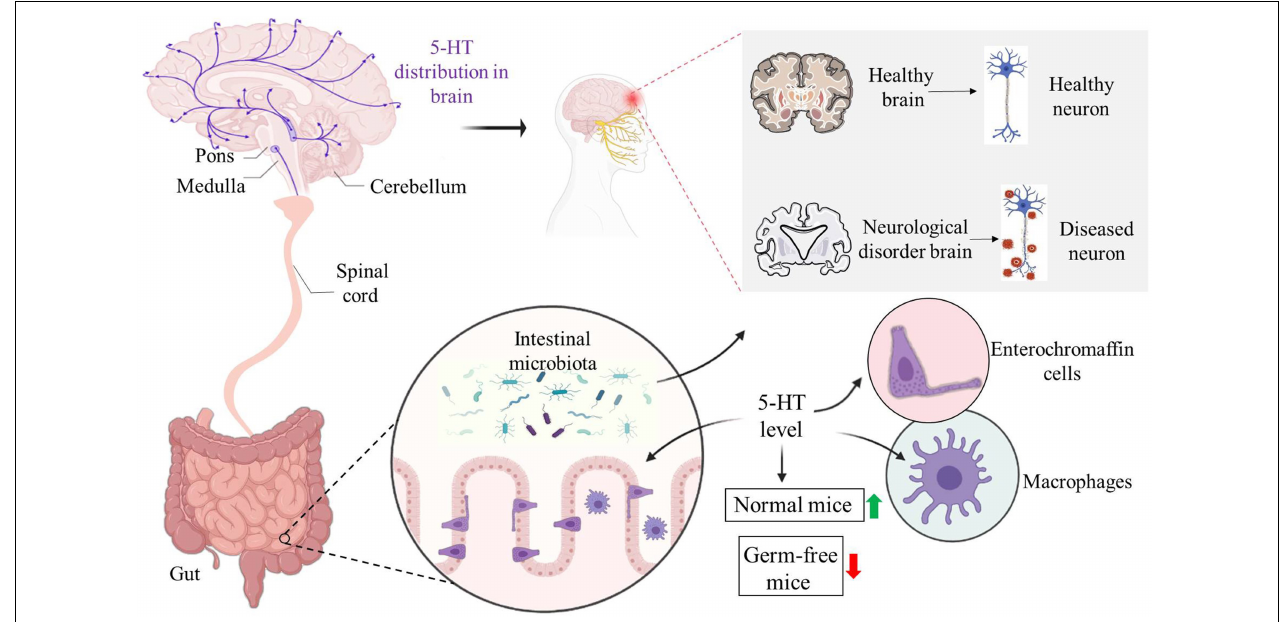
FIGURE 3 | Distributions of 5-HT in the brain and intestine affect the brain nerves. The distribution of 5-HT in the brain affects the state of the brain, which is different between health and neurological diseases. Enterochromaffin cells and macrophages can promote the secretion of 5-HT in the intestine. Compared with normal flora colonized mice, the level of 5-HT in germ-free mice was lower. The level of 5-HT may also regulate the intestinal microecological environment, which can affect the function of the central nervous system and is associated with neurological diseases.